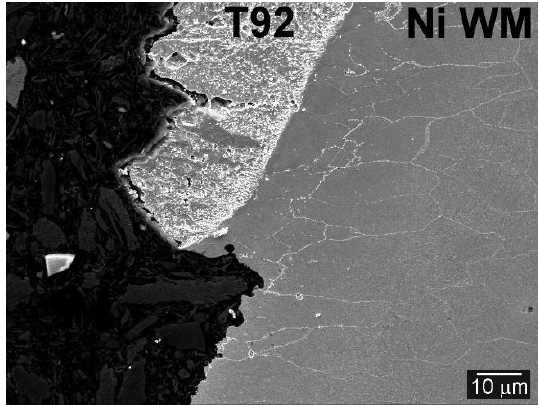
Figure 11. Fracture path along the Type-II boundary and the T92 BM / Ni WM fusion zone, material Figure 11 . Fracture path along the Type-II boundary and the T92 BM/Ni WM fusion zone, material state QT PWHT + 620 ◦ C / 2500 h + H. state QT PWHT + 620 °C/2500 h + H.